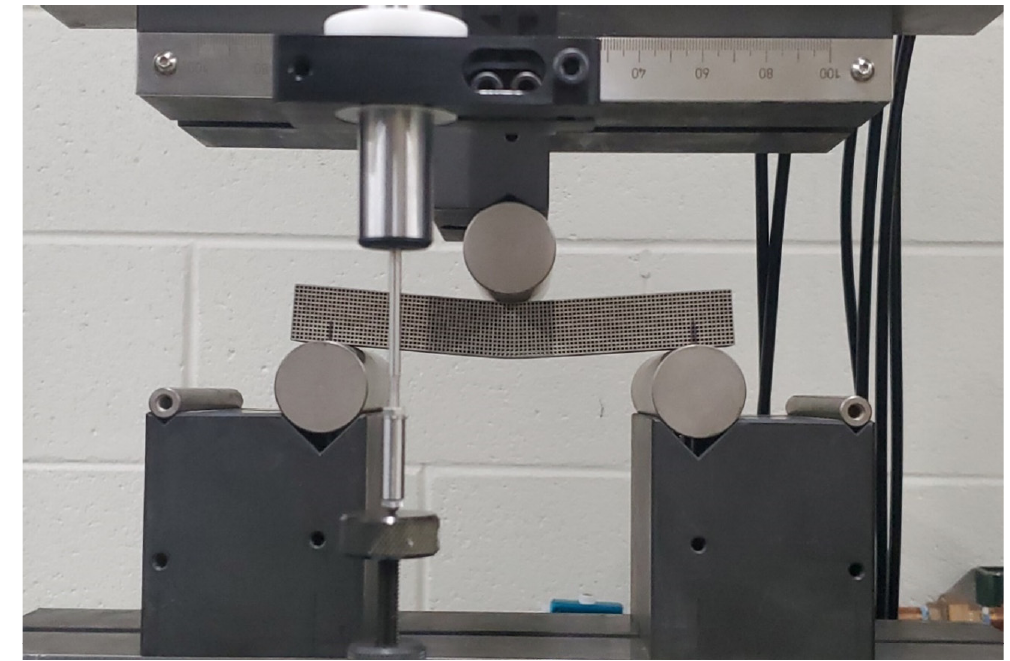
Figure 3. Flexure test for cubic